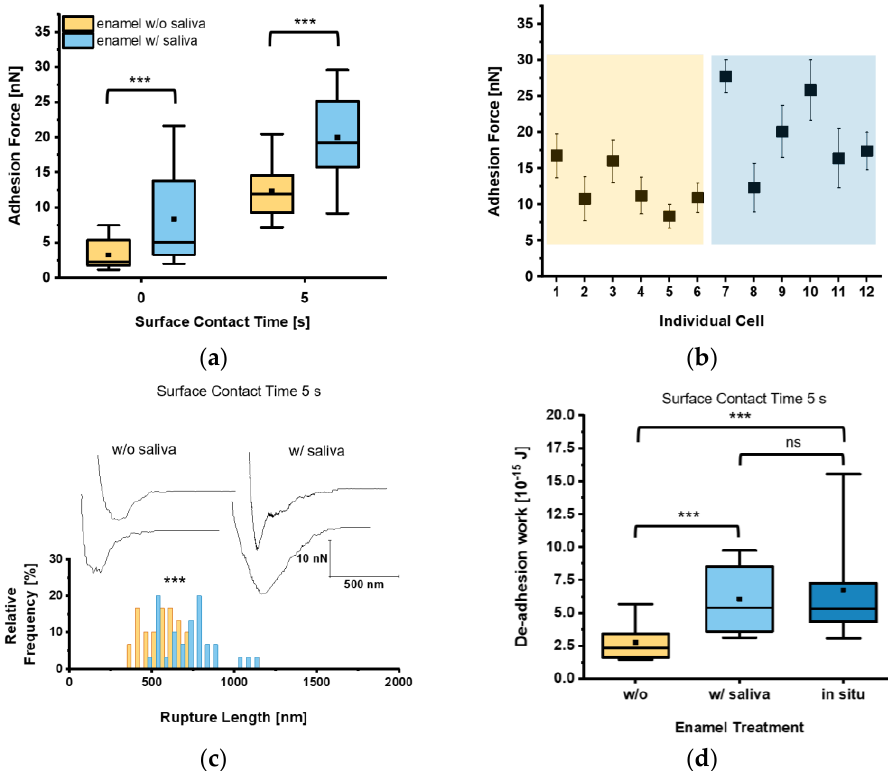
Figure 3. Adhesion of untreated Candida albicans yeast cells to tooth enamel and the impact of salivary pellicle. ( a ) Adhesion forces of C. albicans yeast cells to untreated or saliva-treated enamel and for surface contact time delays of 0 s and 5 s. Data are presented in box and whisker plots (min-to-max), with median (horizontal line) and mean value (closed square). For each box 30 data points of six individual cells with five data points per cell are depicted. ***, p < 0.001 (Mann-Whitney U Test). ( b ) Adhesion forces of individual yeast cells. Shaded areas indicate treatment of the enamel w/o (orange) or w/(blue) saliva. Mean adhesion forces and standard deviations are indicated. ( c ) Representative retraction curves for untreated ( left ) and saliva-treated ( right ) enamel and rupture lengths for a surface contact time delay of 5 s. The histogram for rupture lengths consists of a bin size equivalent to 50 nm. ***, p < 0.001 (Mann-Whitney U Test). ( d ) De-adhesion work of yeast cells for a contact time of 5 s for untreated, saliva-treated, and in situ-exposed tooth enamel. Data are presented in box and whisker plots (min-to-max), with median (horizontal line) and average (closed square). For each box 30 data points of six individual cells with five data points per cell are depicted. ns, not significant; ***, p < 0.001 (Kruskal-Wallis test followed by post-hoc